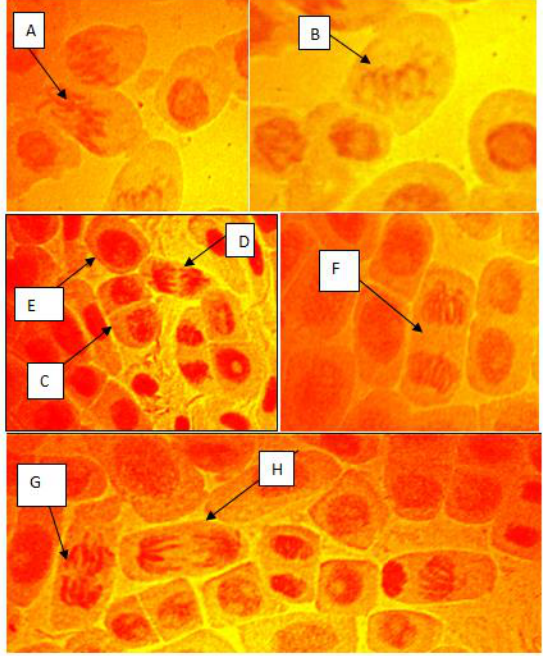
Figure 4. ( A – H ) Chromosomal aberrations observed in root tip cells of Allium cepa exposed to electronic waste ( A ) disturbed spindle and fragmentation, ( B ) sticky chromosome; ( C ) normal prophase; ( D ) normal anaphase; ( E ) interphase; ( F ) normal telophase; ( G ) chromosome bridge; ( H ) laggard